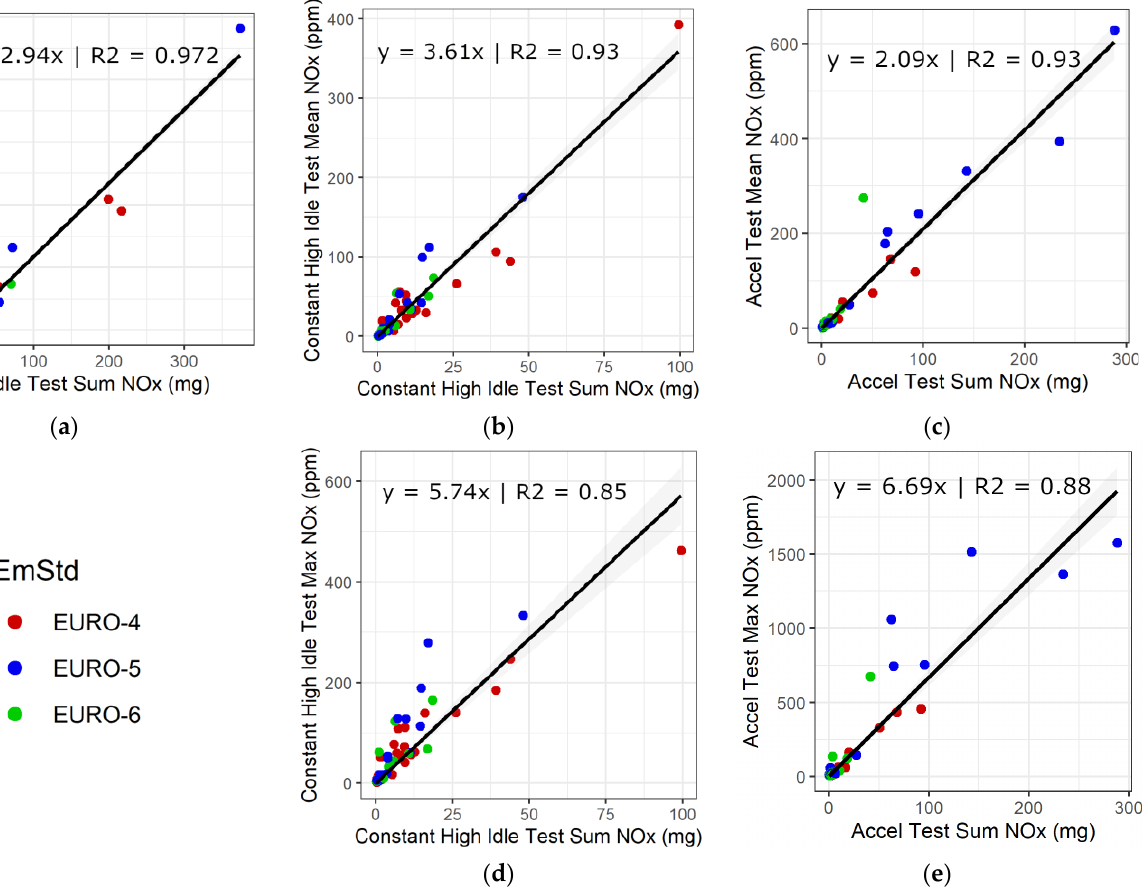
Figure 3. Petrol vehicle mean and maximum NOx concentration vs. total mass emissions over each test section: ( a ) idle test mean NOx; ( b ) high idle test mean NOx; ( c ) acceleration test mean NOx; ( d ) high idle test maximum NOx; ( e ) acceleration test maximum NOx.